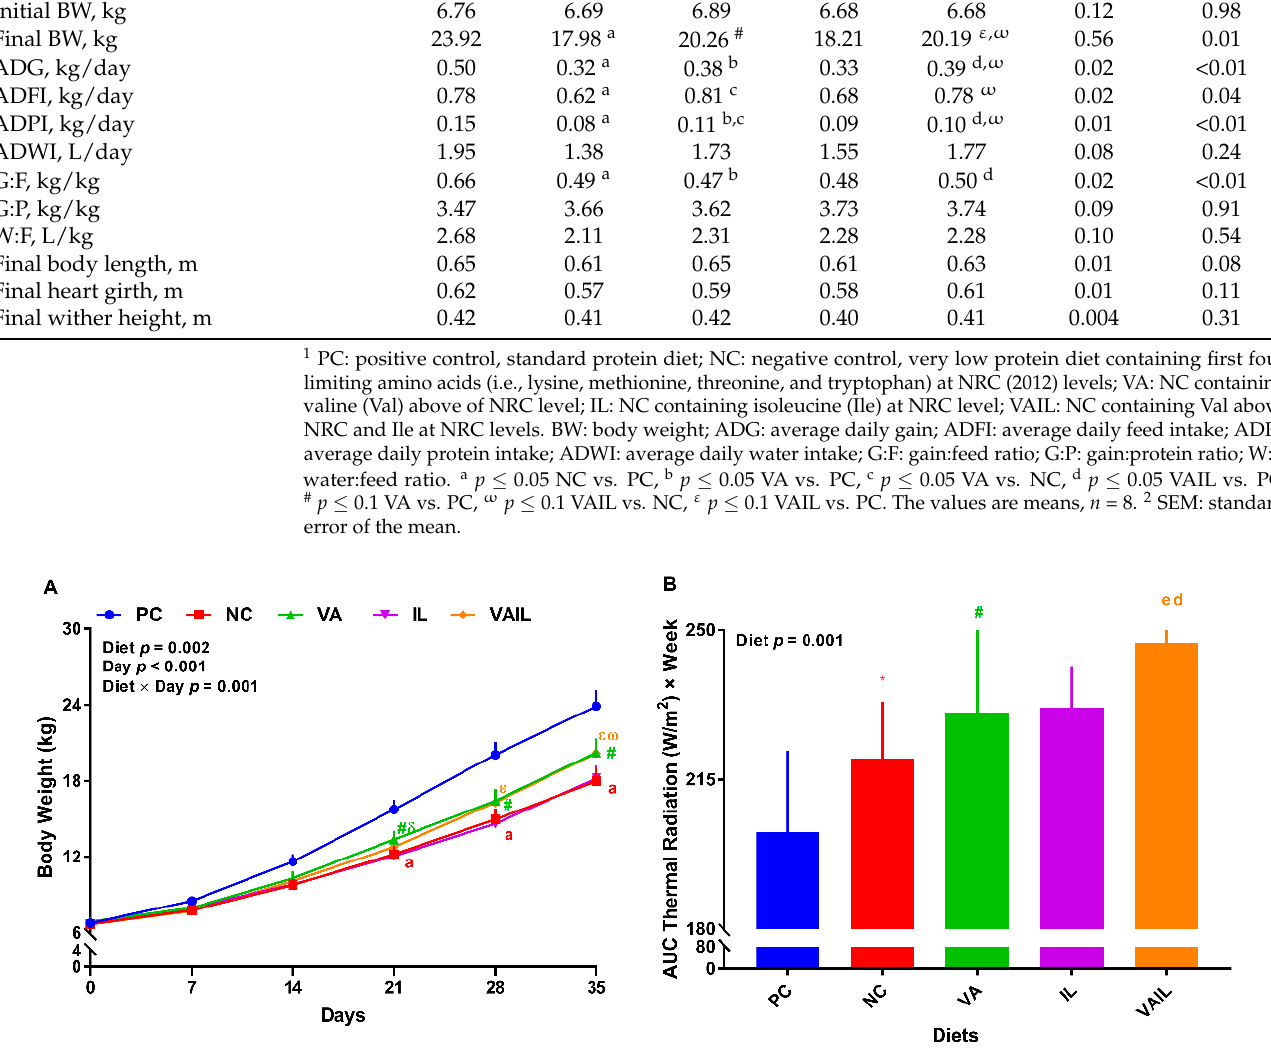
Figure 1. ( A ) Body weight, ( B ) area under the curve (AUC) for thermal radiation of nursery pigs fed with very low protein diets supplemented with isoleucine (Ile) at NRC and valine (Val) above NRC levels, or a combination of the two. PC: positive control, standard protein diet; NC: negative control, very low protein diet containing first four limiting amino acids (i.e., lysine, methionine, threonine and tryptophan) at NRC (2012) levels; VA: NC containing Val above NRC level; IL: NC containing Ile at NRC level; VAIL: NC containing Val above NRC and Ile at NRC levels. a p ≤ 0.05 NC vs. PC d p ≤ 0.05 VAIL vs. PC, e p ≤ 0.05 VAIL vs. NC, * p ≤ 0.1 NC vs. PC, # p ≤ 0.1 VA vs. PC, δ p ≤ 0.1 VA vs. NC, ε p ≤ 0.1 VAIL vs. PC, ω p ≤ 0.1 VAIL vs. NC. Values are means ± standard error of the mean. n = 8.